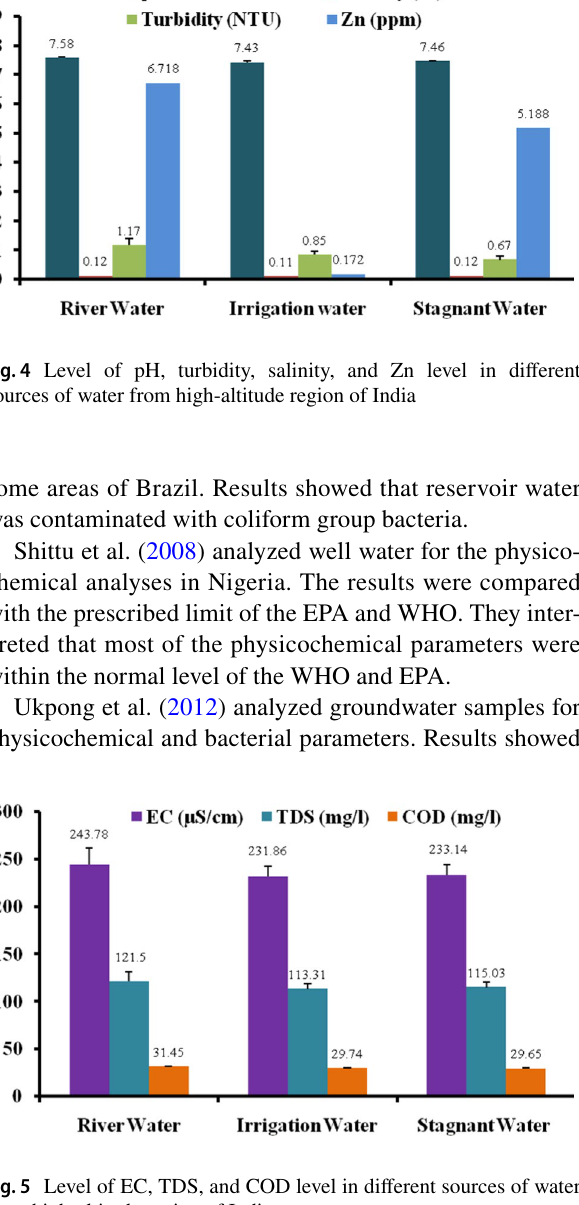
Fig. 5 Level of EC, TDS, and COD level in different sources of water from high-altitude region of